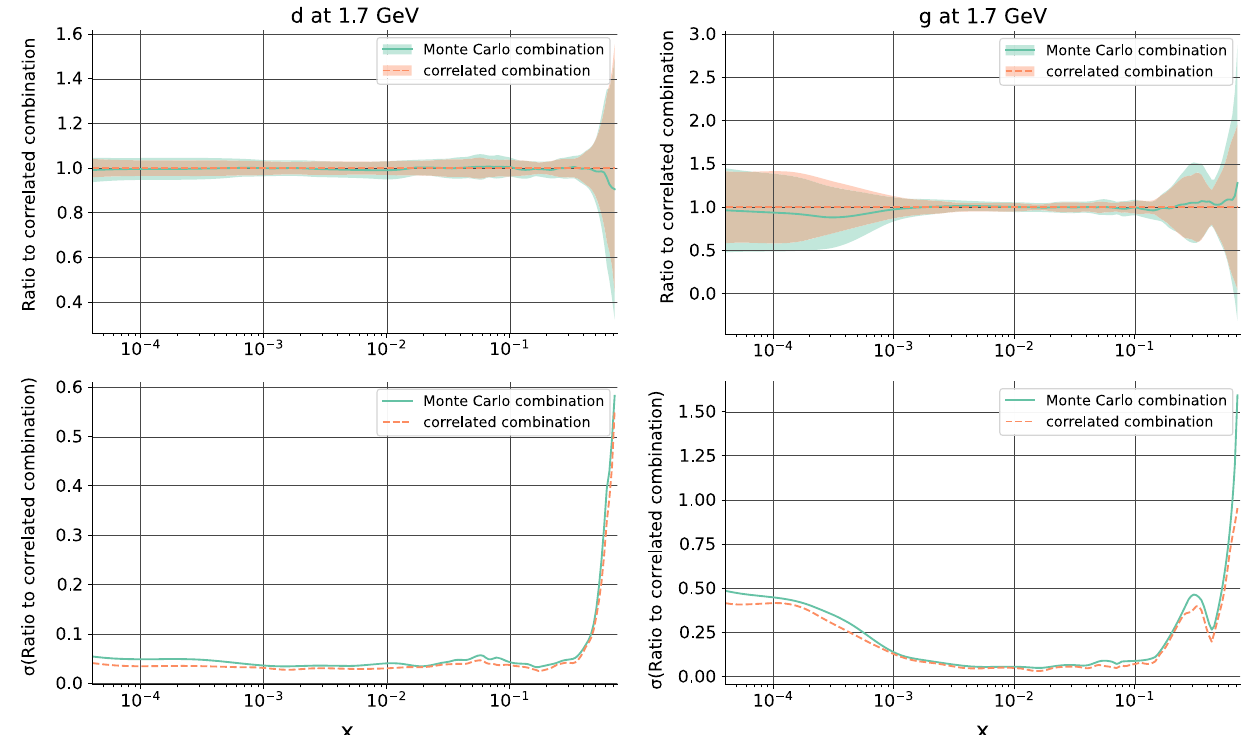
Fig. 7 CheckthattheMonteCarlocombinationEq.(25)andthecorre- lated combination Eq. (21) of PDF sets yield the same answer. Ten sets sets of 43 NNPDF4.0 PDF replicas are combined: (1) as the correlated weighted average Eq. (21) of the ten result from the ten sets determined using the data-driven component Eq. (12) of the S-correlation (corre-